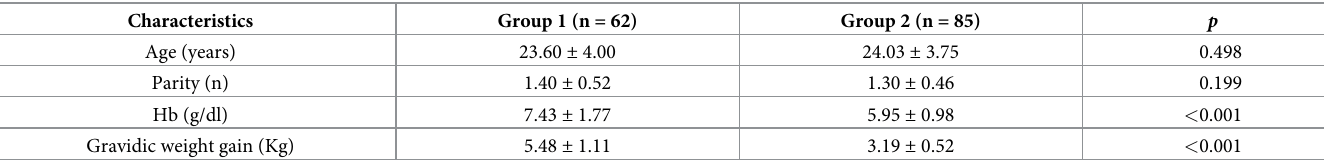
Table 1. Periods and therapeutic doses of artemether during complicated malaria.